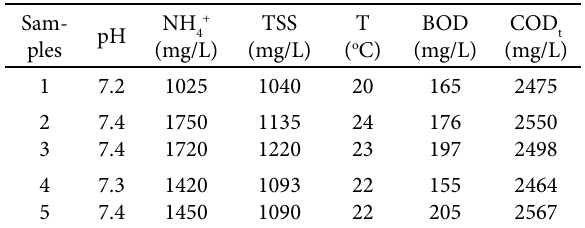
Table 2 . Main characteristics of sludge liquid